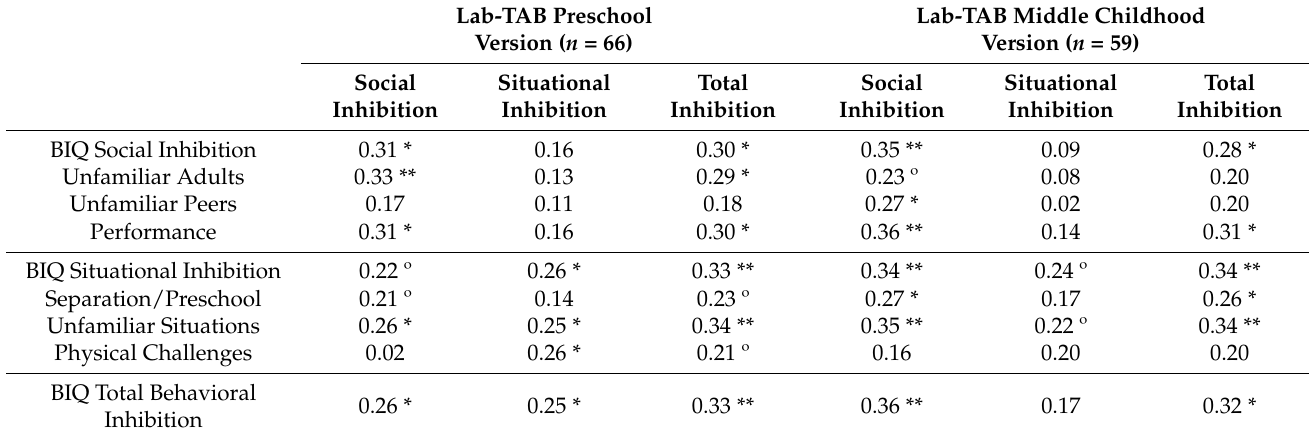
Table 4. Pearson correlation coefficients between Lab-TAB and Behavioral Inhibition Questionnaire (BIQ) inhibition